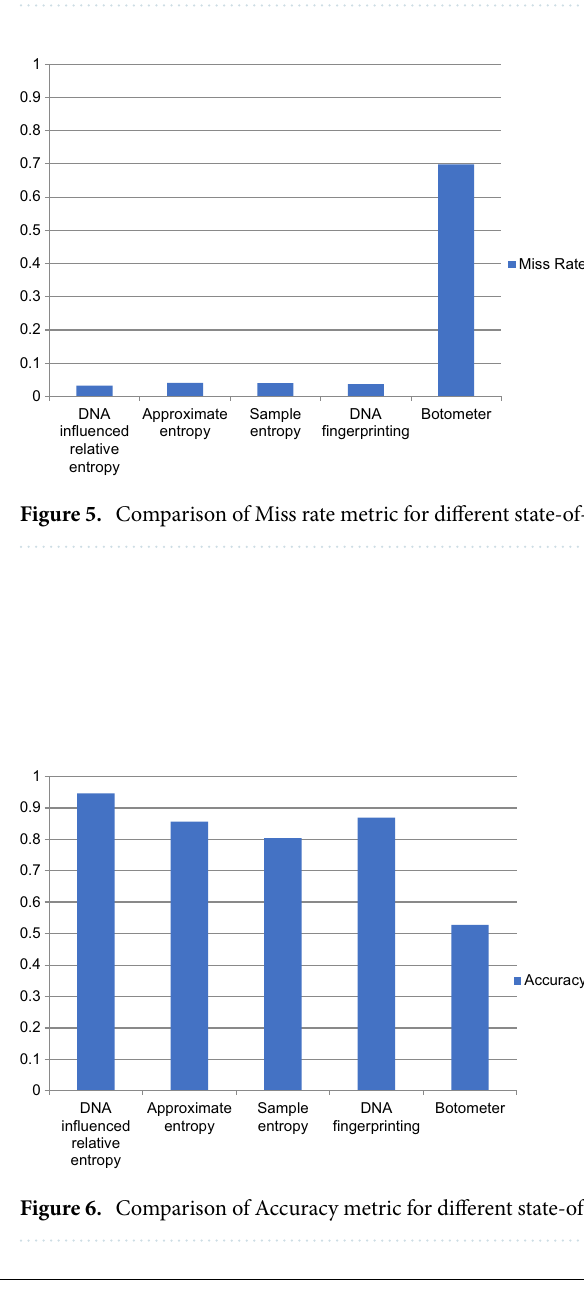
Figure 4. Comparison of Recall metric for different state-of-art approaches.